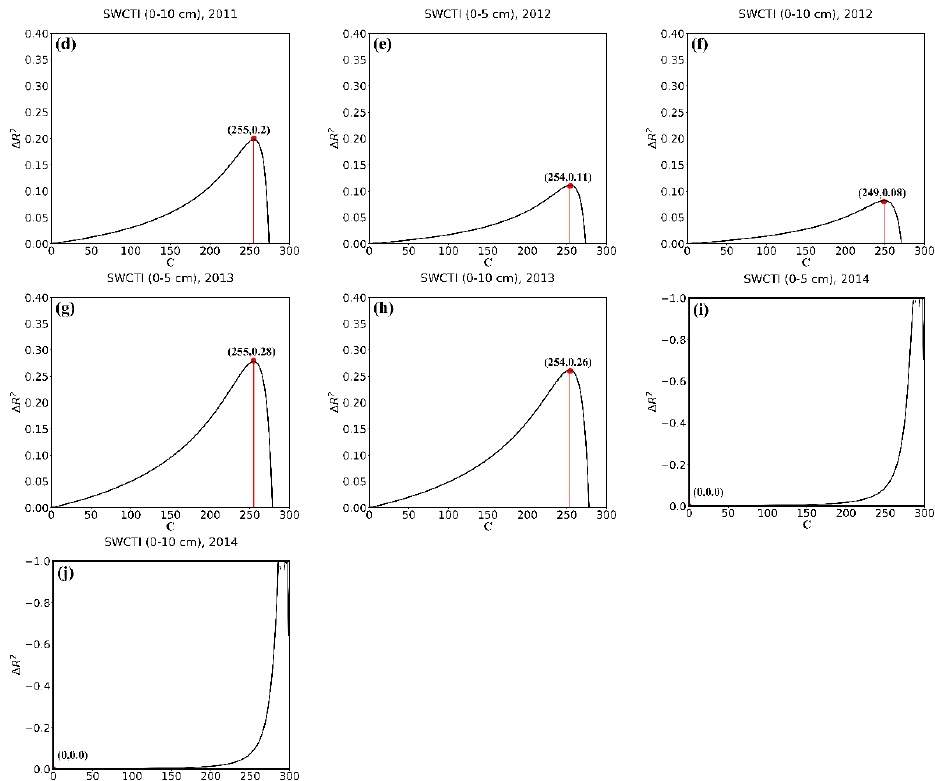
Figure 4. Curves of ∆ R 2 calculated by using the in situ soil moisture data at different soil depths collected in July, August, and September, ( a ) 0–5 cm in 2010, ( b ) 0–10 cm in 2010, ( c ) 0–5 cm in 2011, ( d ) 0–10 cm in 2011, ( e ) 0–5 cm in 2012, ( f ) 0–10 cm in 2012, ( g ) 0–5 cm in 2013, ( h ) 0–10 cm in 2013, ( i ) 0–5 cm in 2014; and ( j ) 0–10 cm in 2014.